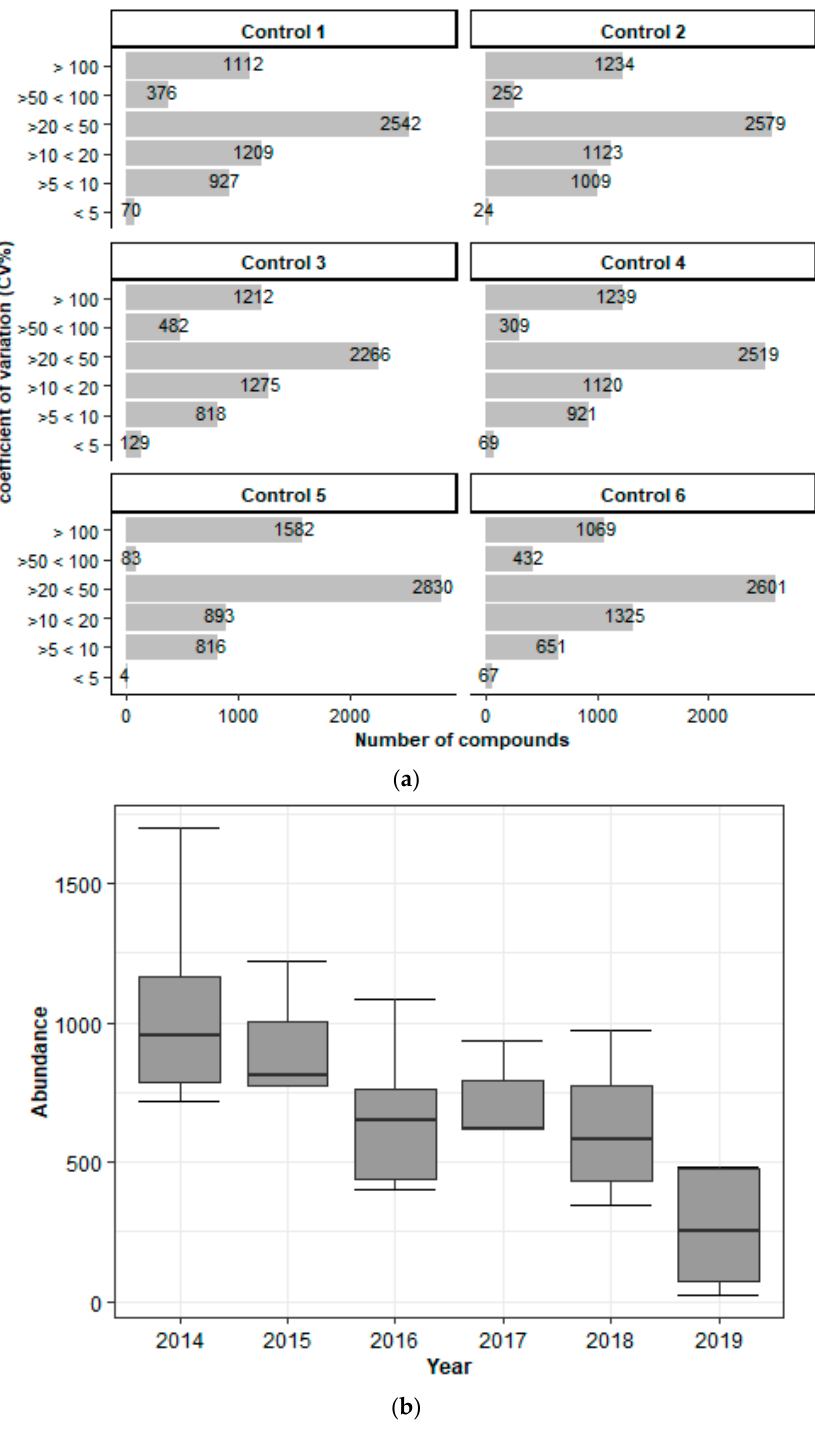
Figure 1. Investigation of the DBS stability. ( a ) The effect of six years of storage on the stability of DBS cards. Per year, blood was drawn from the same individuals (six controls), dripped onto DBS cards within two hours of collection, and stored at − 20 °C. As seen in the figure, the optimal variation (5%) was present in few metabolites, while most of them had variations of up to 50%. ( b ) Box plots show an example of a random compound (7.30_439.3416 m/z ) in DBS samples from the six control subjects collected from 2014 to 2019 and its variation in abundance throughout the years. Box = 25th and 75th percentiles; bars = min and max values.